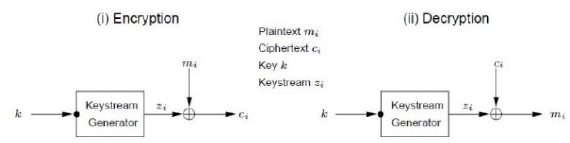
Figure 2: General model of a binary additive stream cipher